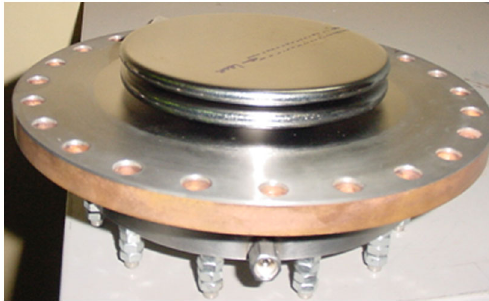
FIG. 4. (Color) The niobium bellows used as the mechanical tuner of the